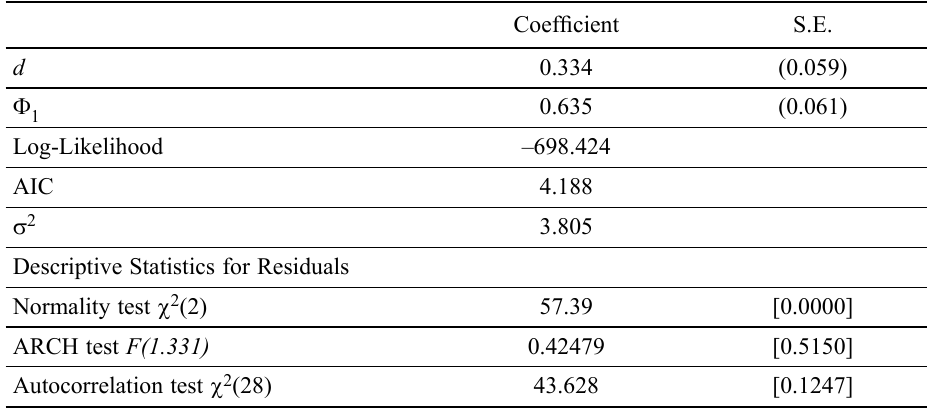
Table 3. Maximum likelihood estimation of ARFIMA (1, d, 0) model: